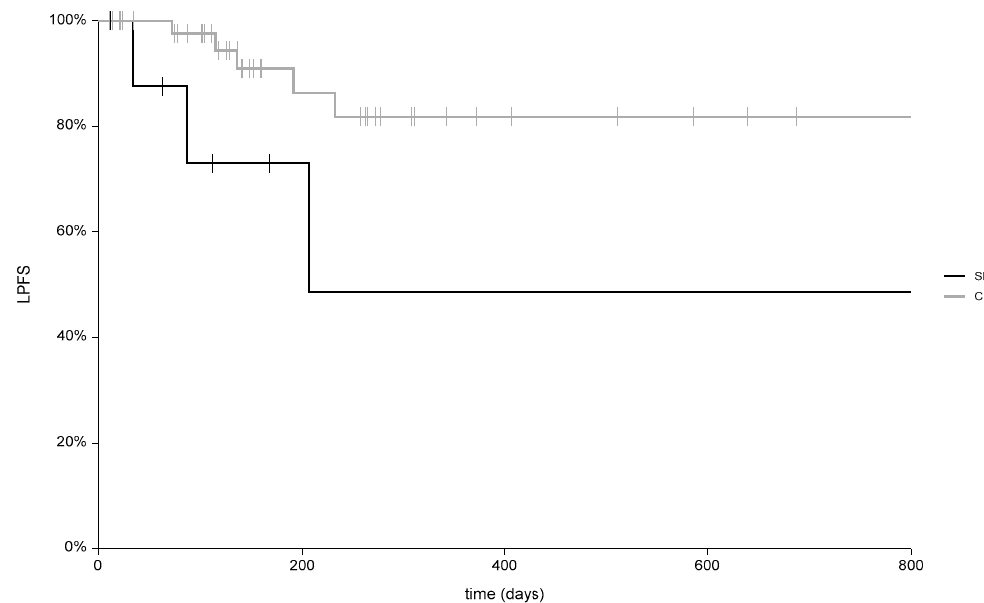
Figure 3. Different local control of disease ( p = 0.007) in patients with complete response (CR) and partial response (PR), compared to patients with stable disease (SD) and progressive disease (PD). (LPFS = local progression-free survival).